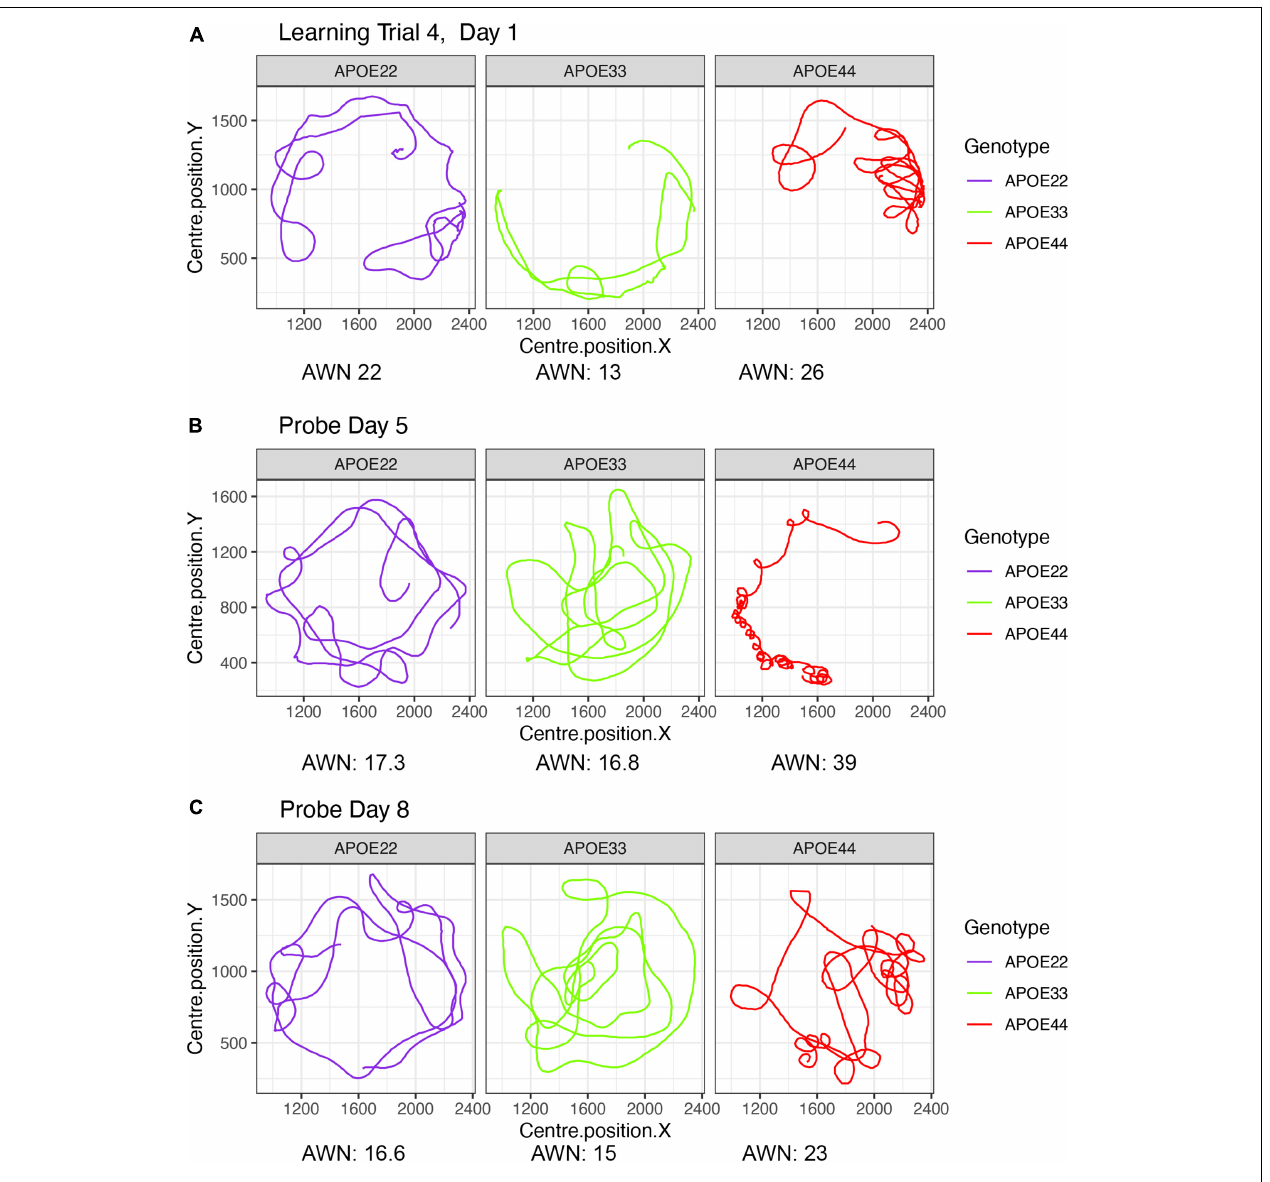
FIGURE 1 | Examples of swim paths shapes for animals with APOE2, APOE3, and APOE4 genotypes. Qualitative observations suggest that swim paths differed not just in length, but also in shape. Trajectories are presented for the last trial in day 1 (A) , probe in day 5 (B) , and probe in day 8 (C) . We chose animals illustrating medium (APOE2: learning = 22, d5 = 17.3; d8 = 16.6), medium-small (APOE3: learning = 13, d5 = 16.8, d8 = 15), and large winding numbers (APOE4: learning = 26, d5 = 39; d8 = 23). APOE22, homozygous for APOE2; APOE33, homozygous for APOE3; APOE44, homozygous for